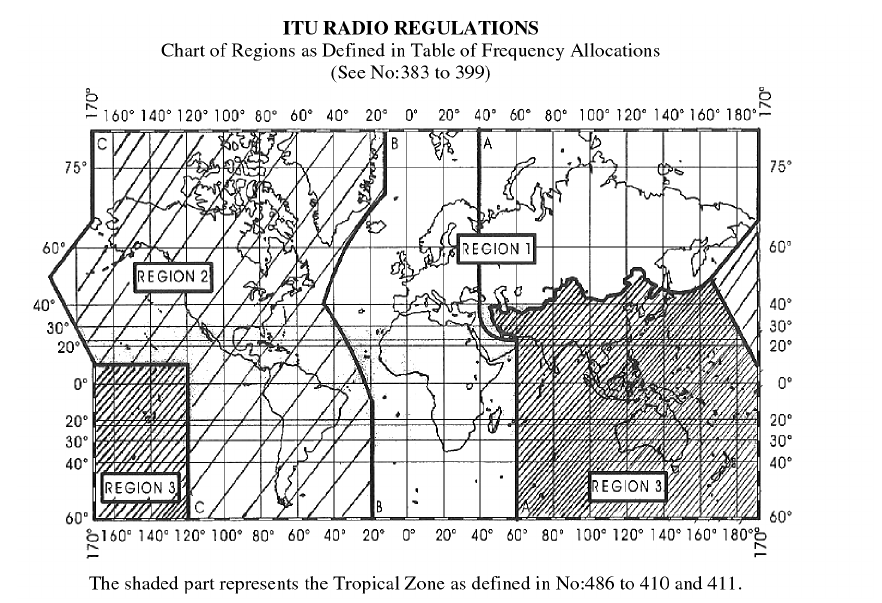
Fig. 1.2. The separate ITU geographical regions (hatched) and the Tropical Zone (dark